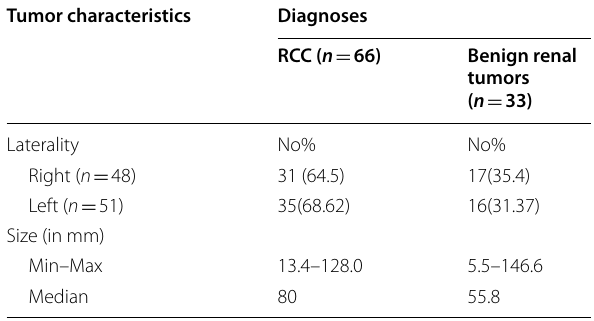
Table 1 Size and laterality characteristics of the lesions in the study populations